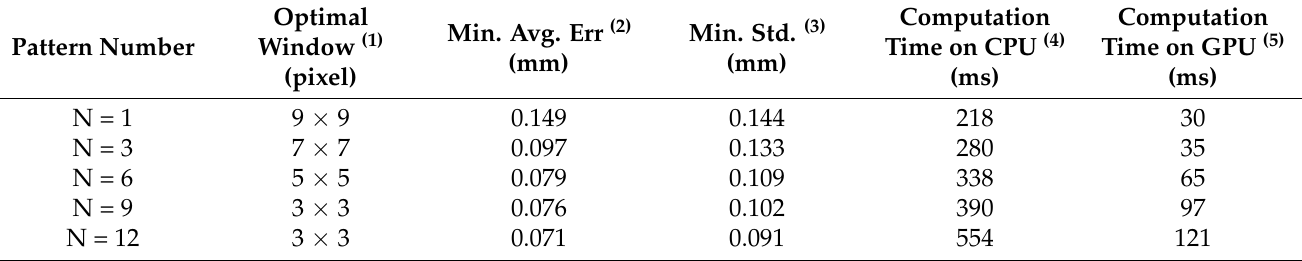
(1) Optimal matching window corresponding to the pattern number. (2) Minimum average error of fitting the face mask between ours and Core 300. (3) Minimum standard derivation of fitting the face mask between the proposed method and Core 300. (4) : The computation time on the CPU when the optimal matching window corresponds to N. (5) : Computation time on the GPU when the optimal matching window corresponding to